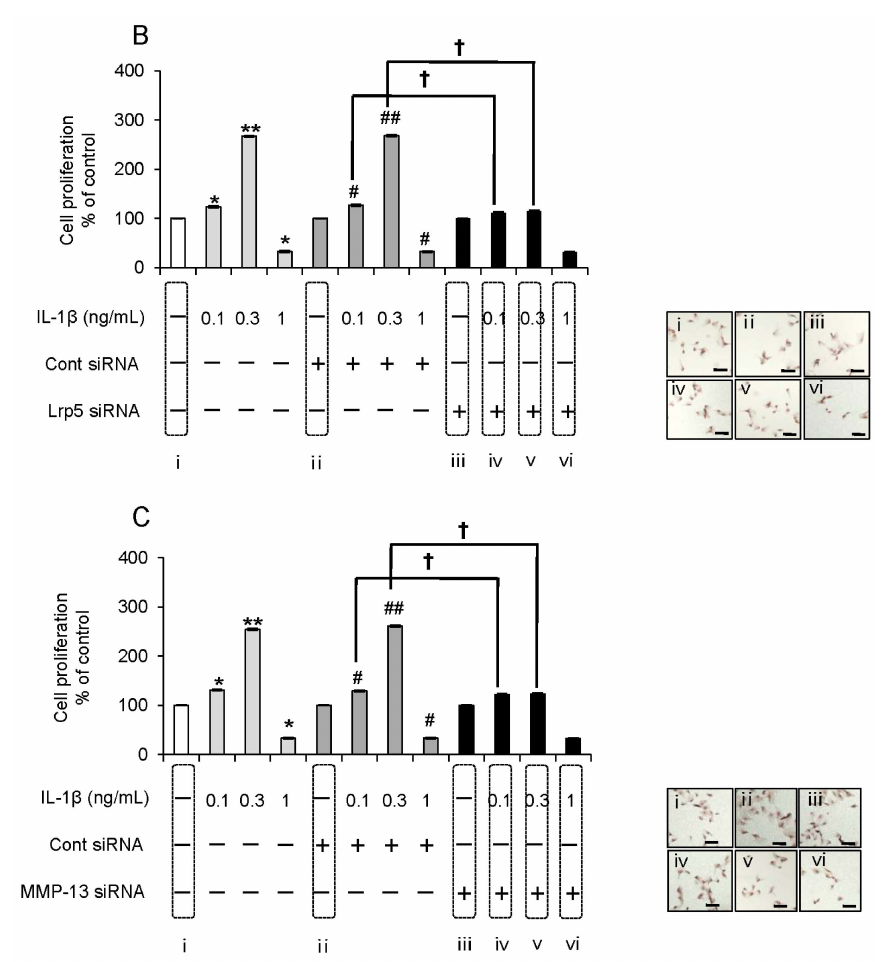
Figure 5. Effect of Wnt16, Lrp5, and MMP-13 siRNAs on IL-1 β -induced cell proliferation. ( A – C ) α 7 + hSMSC-OB cells were transfected for 24 h with Wnt16, Lrp5, and MMP-13 siRNAs, stimulated with IL-1 β (0, 0.1 0.3, and 1 ng/mL), and then analyzed by the BrdU-cell proliferation ELISA (graphs) and BrdU immunohistochemistry kit (images, right row). * p < 0.01 vs. control; ** p < 0.01 vs. control; # p < 0.01 vs. control siRNA; ## p < 0.01 vs. control siRNA; † p < 0.01. The BrdU immunohistochemistry kit stains the nuclei of proliferating cells (dark brown). Images are representative of at least three independent experiments. Scale bars = 100 µ